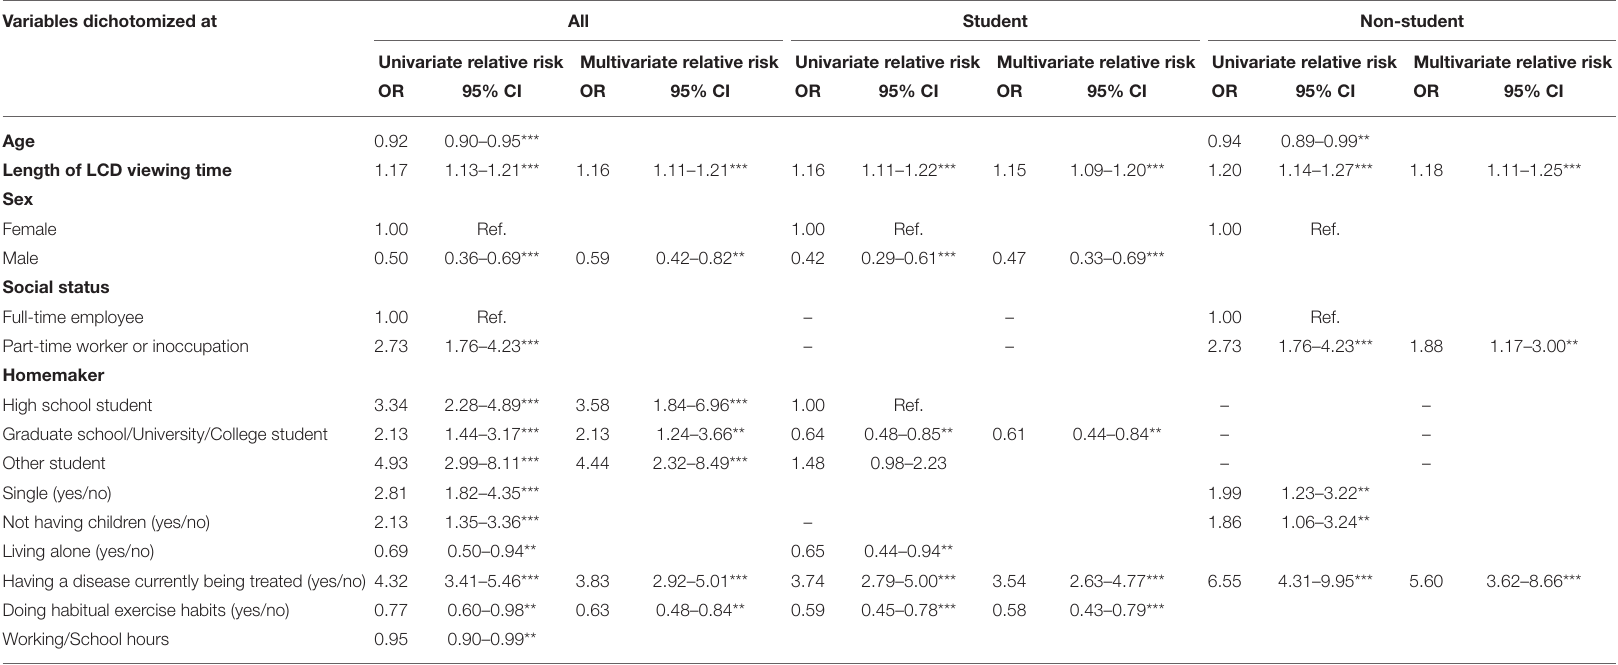
TABLE 4 | Logistic regression analyses of factors associated with the risk of DSWPD. Variables dichotomized